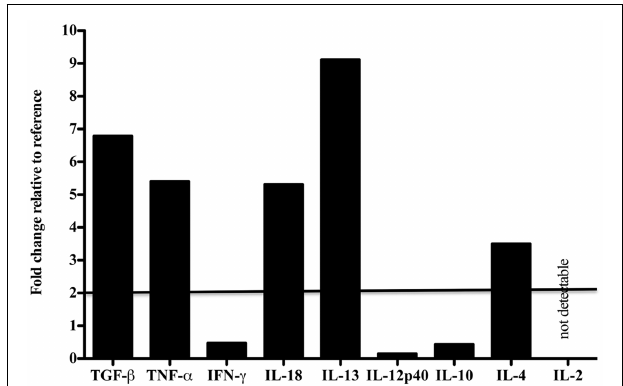
FIGURE 2 | Cytokine message levels in the liver of a dolphin with hyperinsulinemia . In the liver, each target gene was determined by real-time PCR and normalized first to S-9, a ribosomal control gene to give a ∆ Ct.The ∆∆ Ct was determined for the dolphin with hyperinsulinemia by normalizing to a healthy control.The ∆∆ Ct were transformed (2 − ∆∆ Ct ) to show the expression of each cytokine message as a fold change. A fold change of 2 or more was considered to be upregulated in the dolphin with hyperinsulinemia.